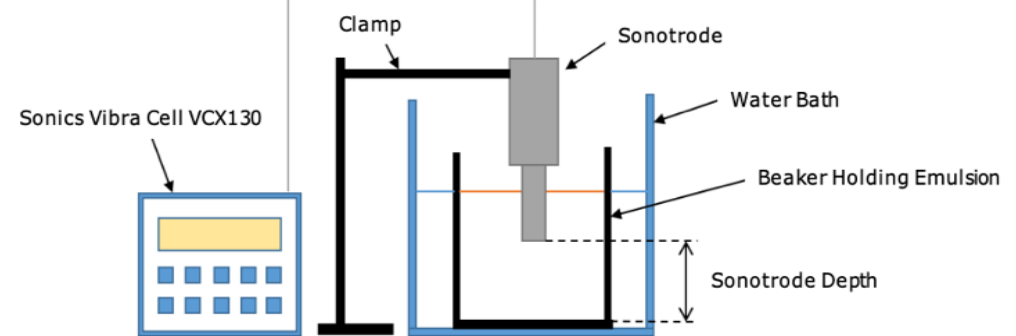
Figure 6. Experimental setup.